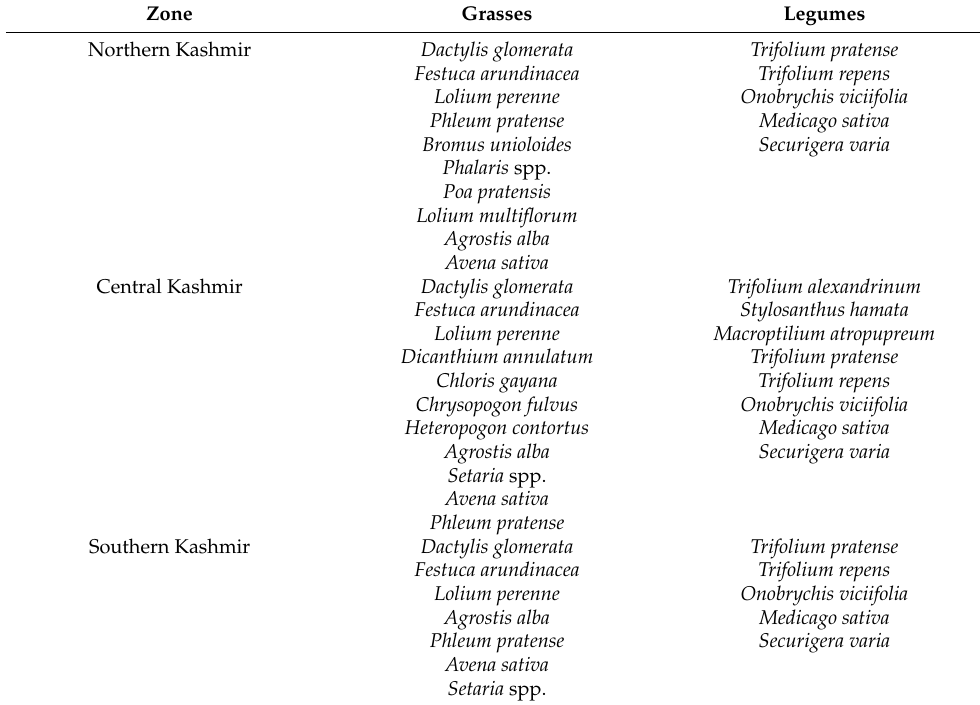
Table 10. Diversity of grasses and legumes in the studied Kashmir